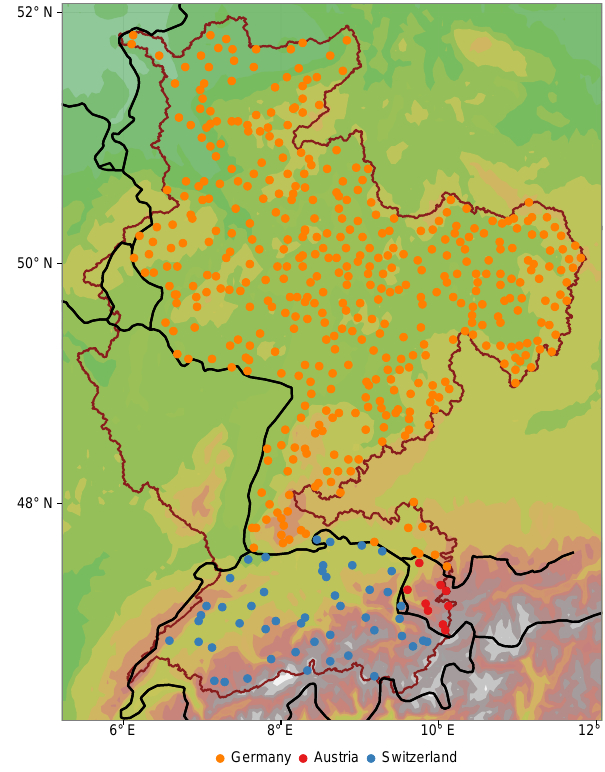
Figure 1. Locations of the climate data stations used. See text for more details on single data sets. The dark red line shows the Rhine catchment; the black lines denote state